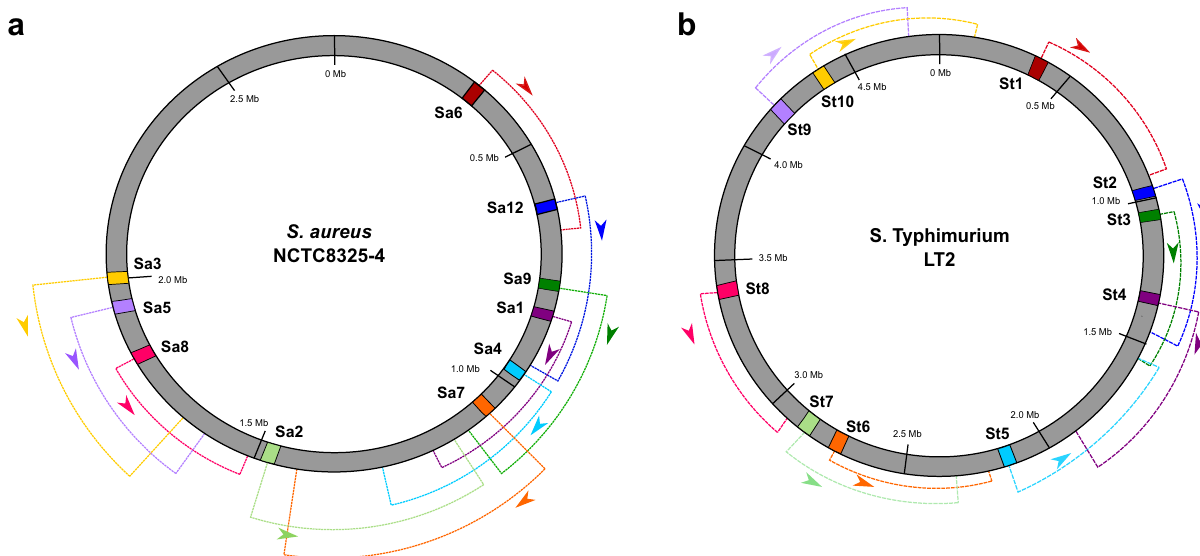
Fig. 4 Potential for extensive DNA transfer via lateral transduction is dictated by the distribution of prophage attachment sites in the bacterial chromosome. Map of the chromosomes of S. aureus NCTC8325-4 ( a ) and S. Typhimurium LT2 ( b ) indicating the ten potential chromosomal attachment ( attB ) sites available for prophage integration. The packaging direction of an integrated prophage from each attB site is indicated by its corresponding colour-coded arrow, with the dashed regions representing a distance of approximately seven headfuls (one headful = ~45 kb for 80 α ) in S. aureus , or 12 headfuls (one headful = ~43 kb for P22) in S. Typhimurium from the attB site, which is the minimum distance known to be packaged by LT for each phage. a The distribution and directionality of attB sites in the S. aureus NCTC8325-4 chromosome indicates the potential for transfer of the entire region between ~0.31 and 2.0 Mb from a poly-lysogenic background, representing approximately 58% of the bacterial chromosome. Adapted from ref. 4 . b The distribution and directionality of attB sites in S. Typhimurium LT2 indicates the potential for transfer of up to 3.5 Mb of chromosomal DNA from a poly-lysogenic background, representing approximately 72% of the bacterial chromosome. Source data are provided as a Source Data fi